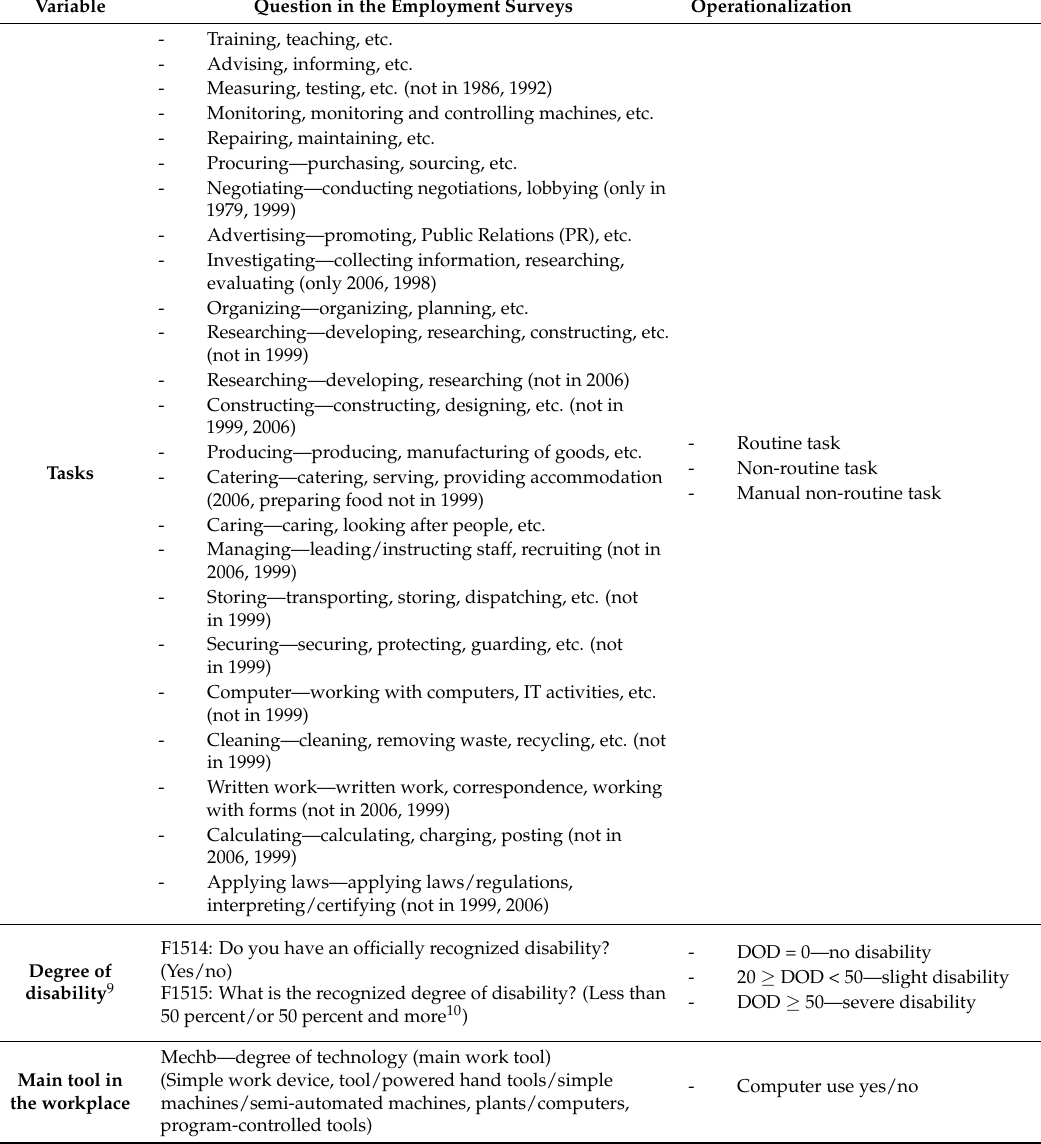
Table A2. Summary of all variables taken into